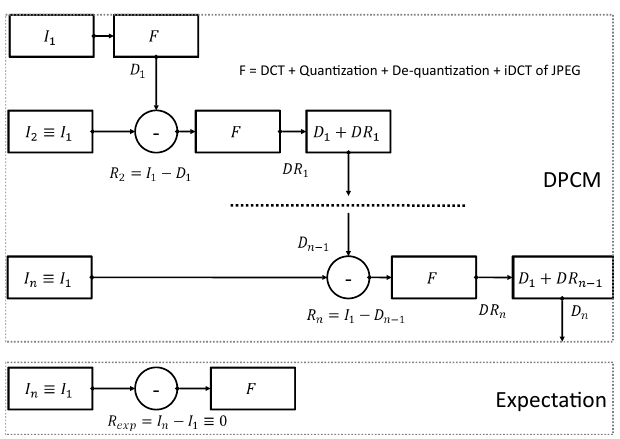
Figure 2. Simulation model of effects of quantization error on inter